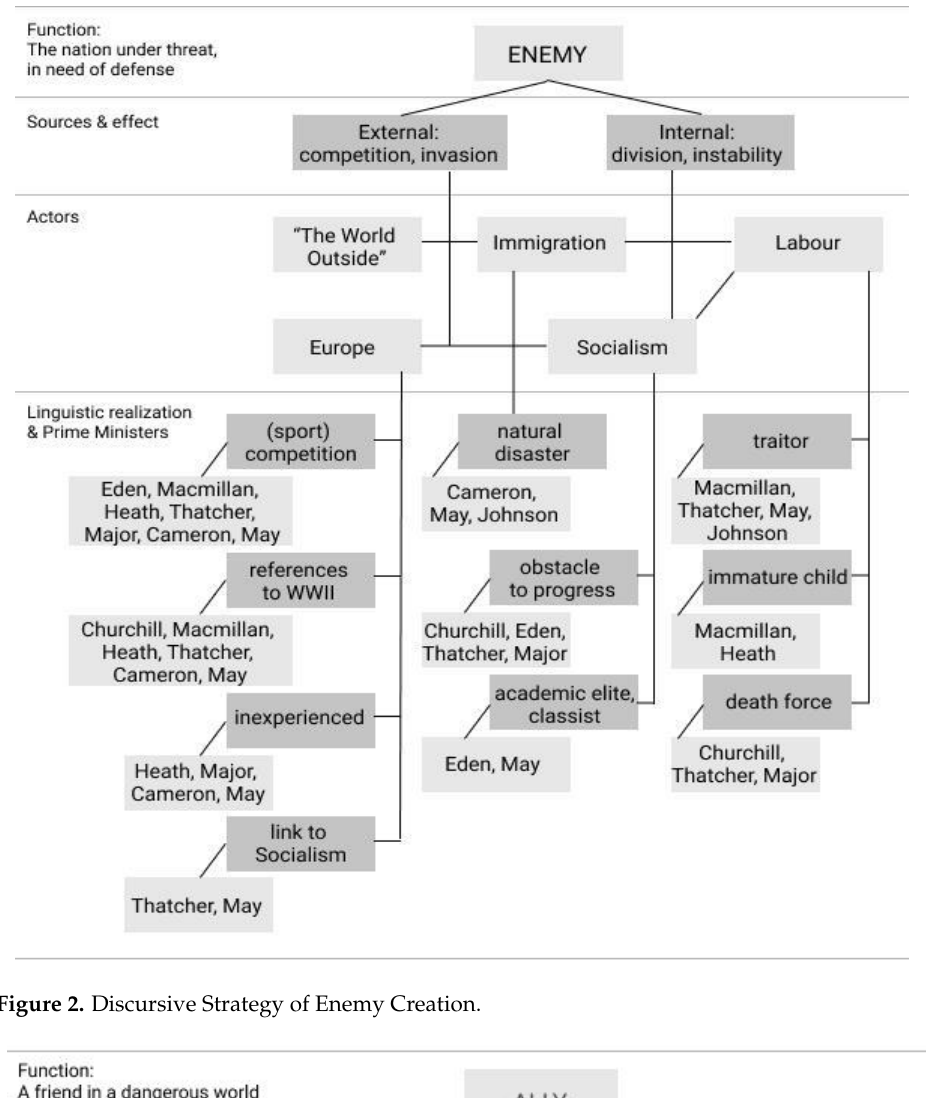
Figure 1. Discursive Strategies of National Identity.